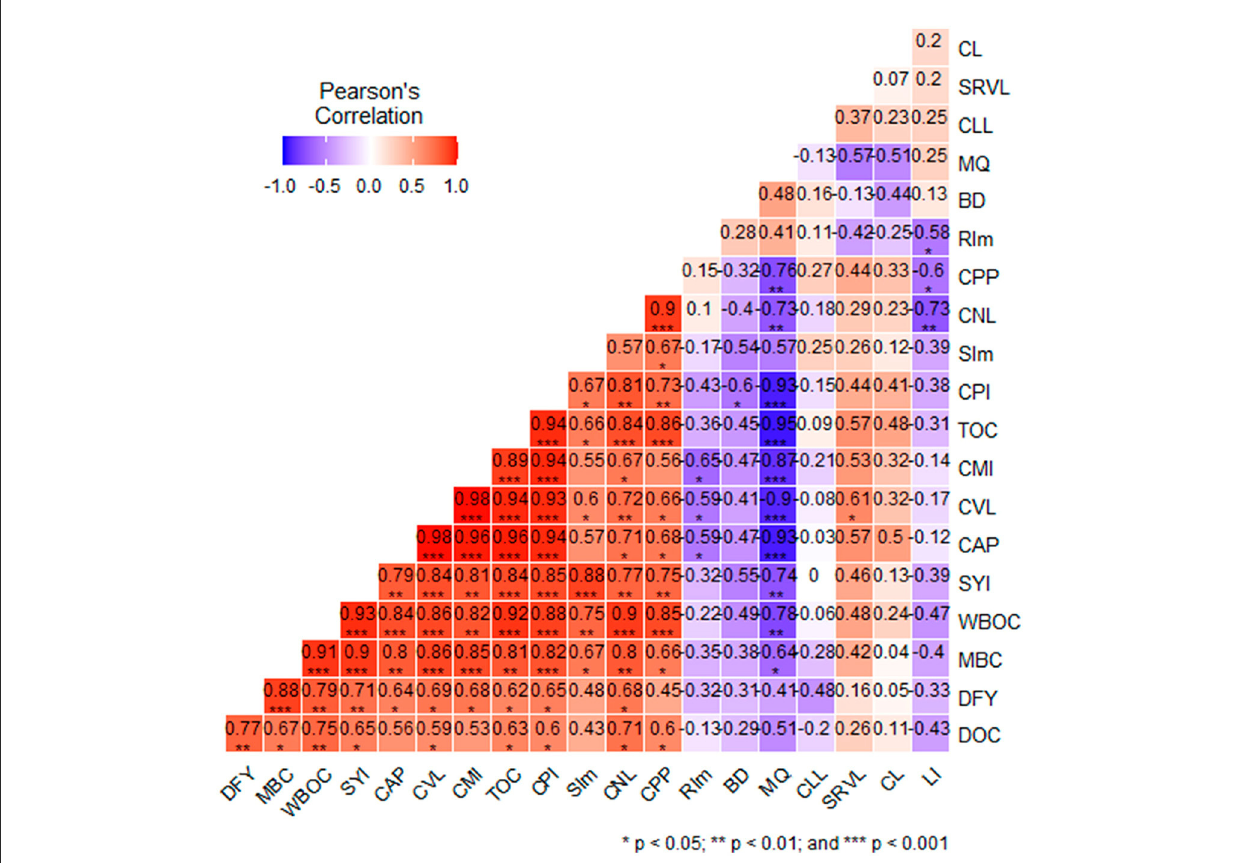
FIGURE2 Correlation matrix among system yield attributes and SOC pools and their indices; DFY, dry forage yield; SYI, sustainable yield index; MBC, microbial biomass carbon; WBOC, Walkley–Black organic carbon; TOC, total organic carbon; DOC, dissolved organic C; RI mean , mean recalcitrant index; C VL , very labile pool of soil organic carbon; C L , labile pool of soil organic carbon; C LL , less labile pool of soil organic carbon; C AP , active pool of soil organic carbon; C PP , passive pool of soil organic carbon; RI m , mean recalcitrant indices; CPI, carbon pool index; CMI, carbon management index;